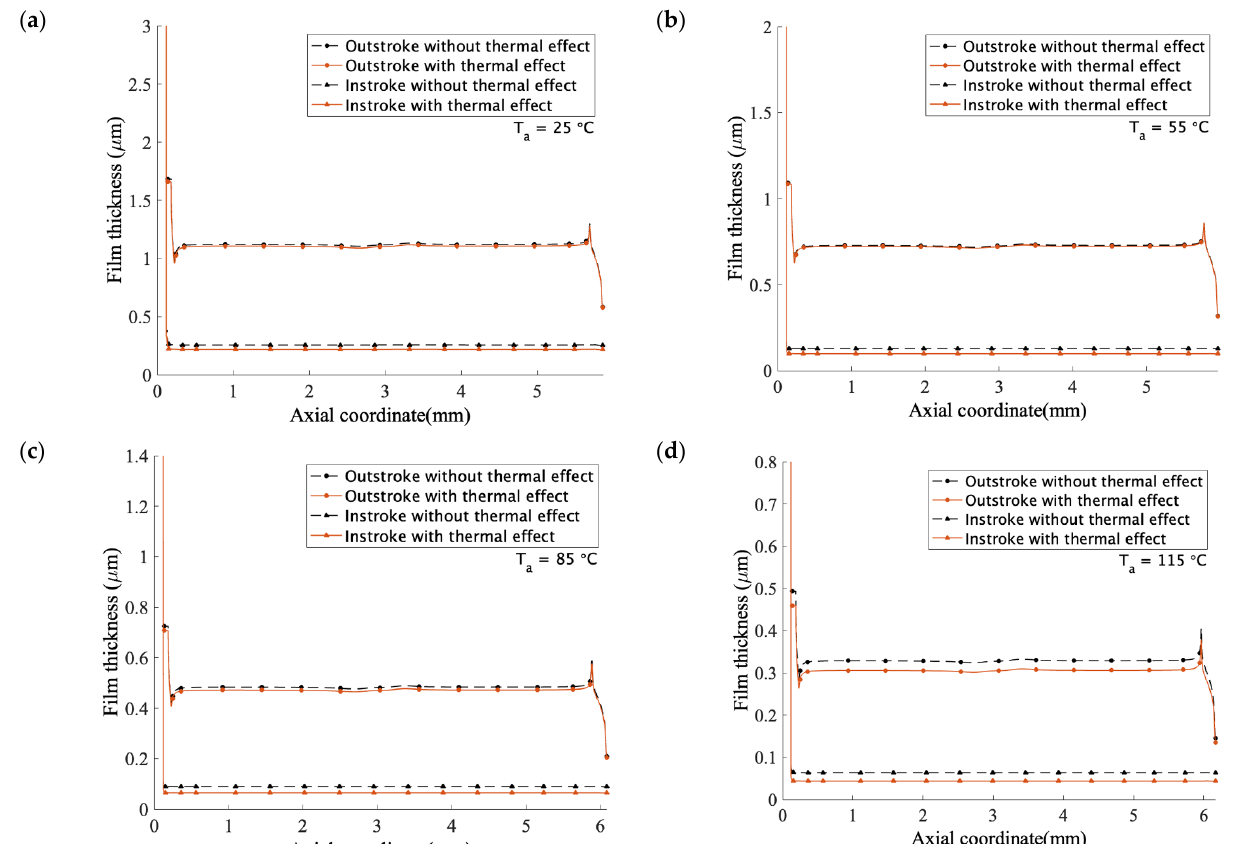
Figure 8. Film thickness distribution according to different ambient temperatures and whether thermal effects are considered: (a) 𝑇 𝑎 = 25℃ , (b) 𝑇 𝑎 = 55℃ , (c) 𝑇 𝑎 = 85 ℃ , and (d) 𝑇 𝑎 = 115 ℃ .